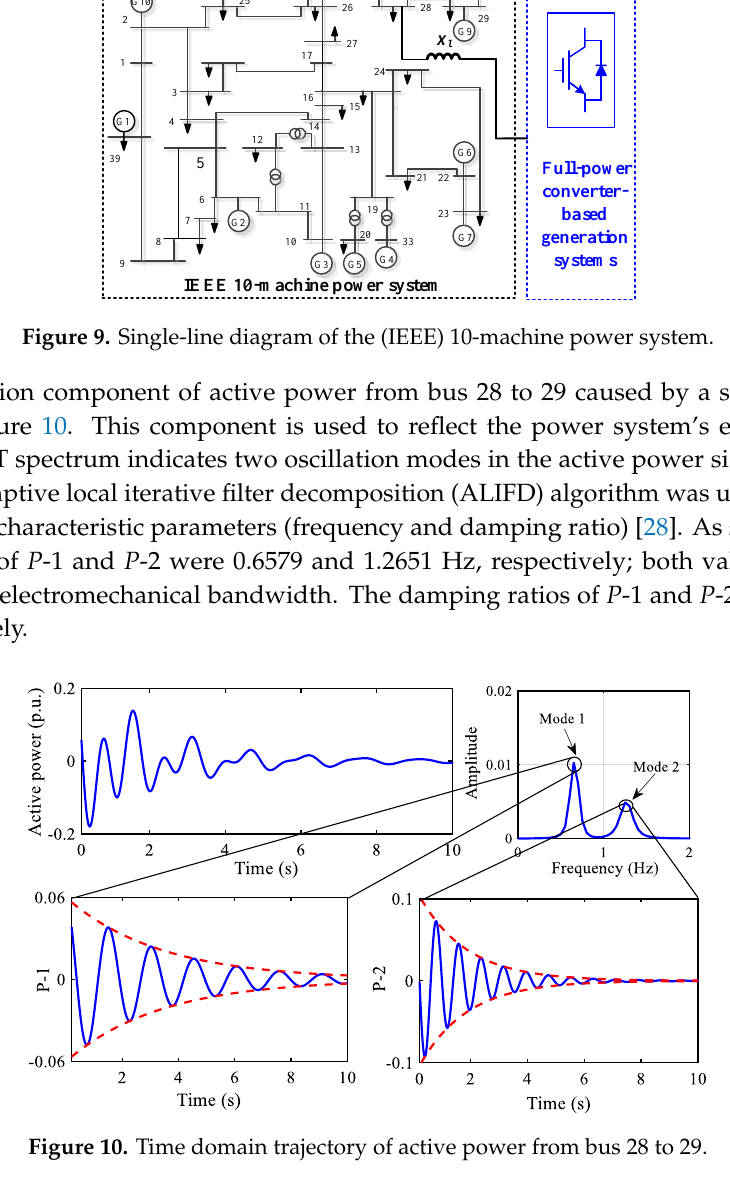
Figure 10. Time domain trajectory of active power from bus 28 to 29. Table 2. Oscillation parameters of active power in